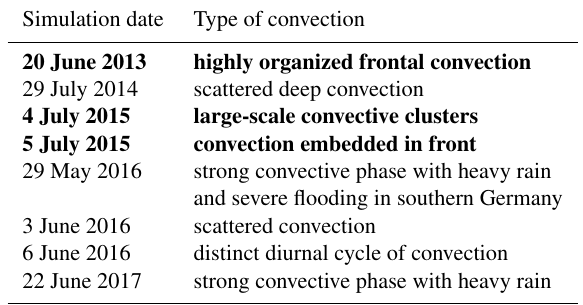
Table 1. Description of simulated convective days. Focus days ana- lyzed in more detail in Sects. 2, 5.2, and 6 are marked in bold font.